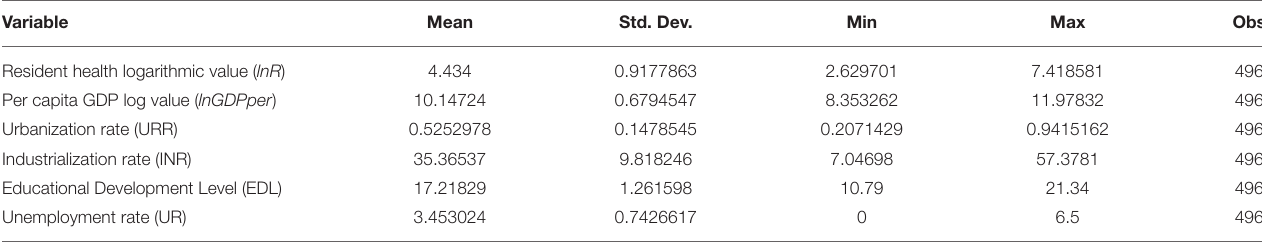
TABLE 1 | Descriptive statistics of related variables.